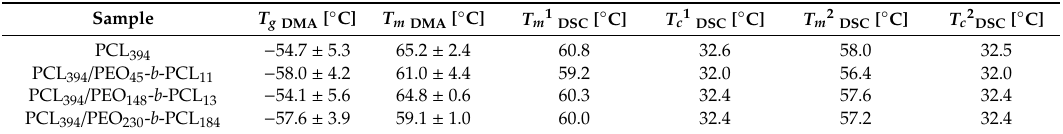
Table 2. T g and T m of PCL materials measured by DMA ( n = 3) and T m and T c studied by DSC before and after a heating/cooling cycle.